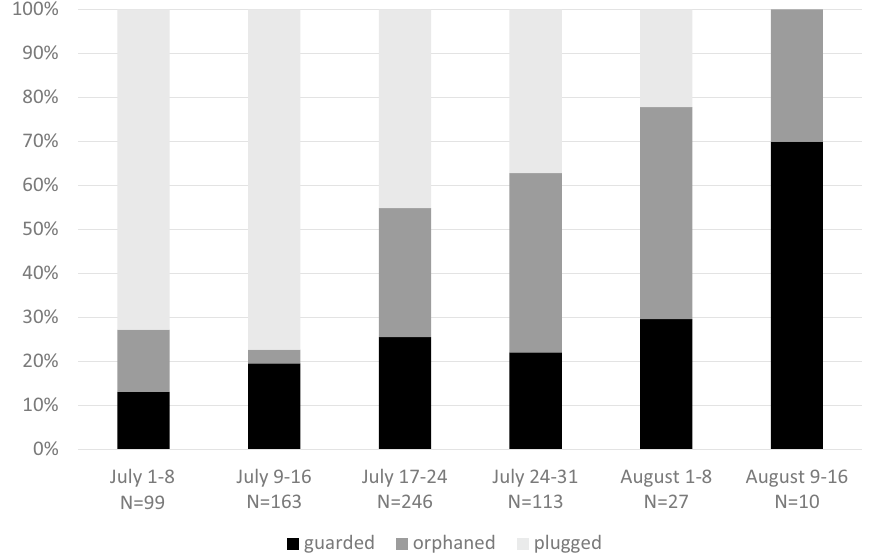
Figure 4. Proportion of types of full brood nests through the season.